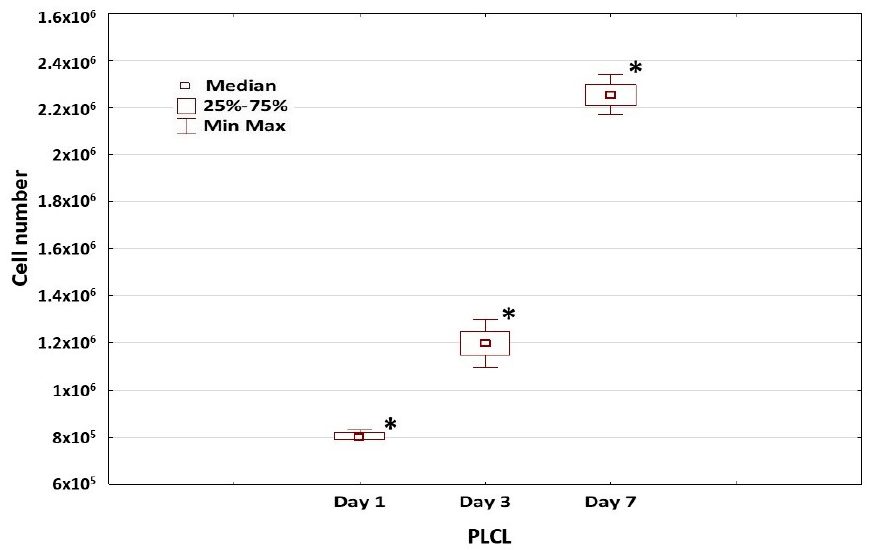
Figure 5. Spreading of hDPSCs grown on the PLCL scaffold. The number of hDPSCs grown onto PLCL significantly increased over time of cultivation (* p < 0.03). Columns show median spreading of hDPSCs ± SD. Three repeated assays were performed for each case ( n = 4). Data are presented as median ± SD ( n = 4).